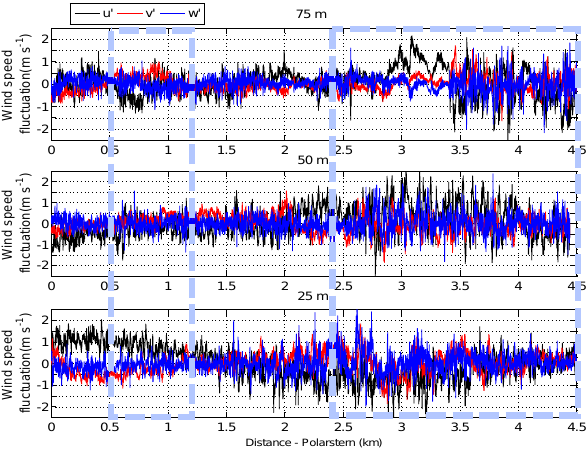
Figure 14. Time series of wind speed fluctuations during the M 2 AV flights at 75, 50 and 25 m altitude (from ( top ) to ( bottom )). The three components of the wind speed vector are defined positive as eastwards (black), northwards (red) and upwards pointing (blue). The parts of the flight track above open water are indicated by light blue